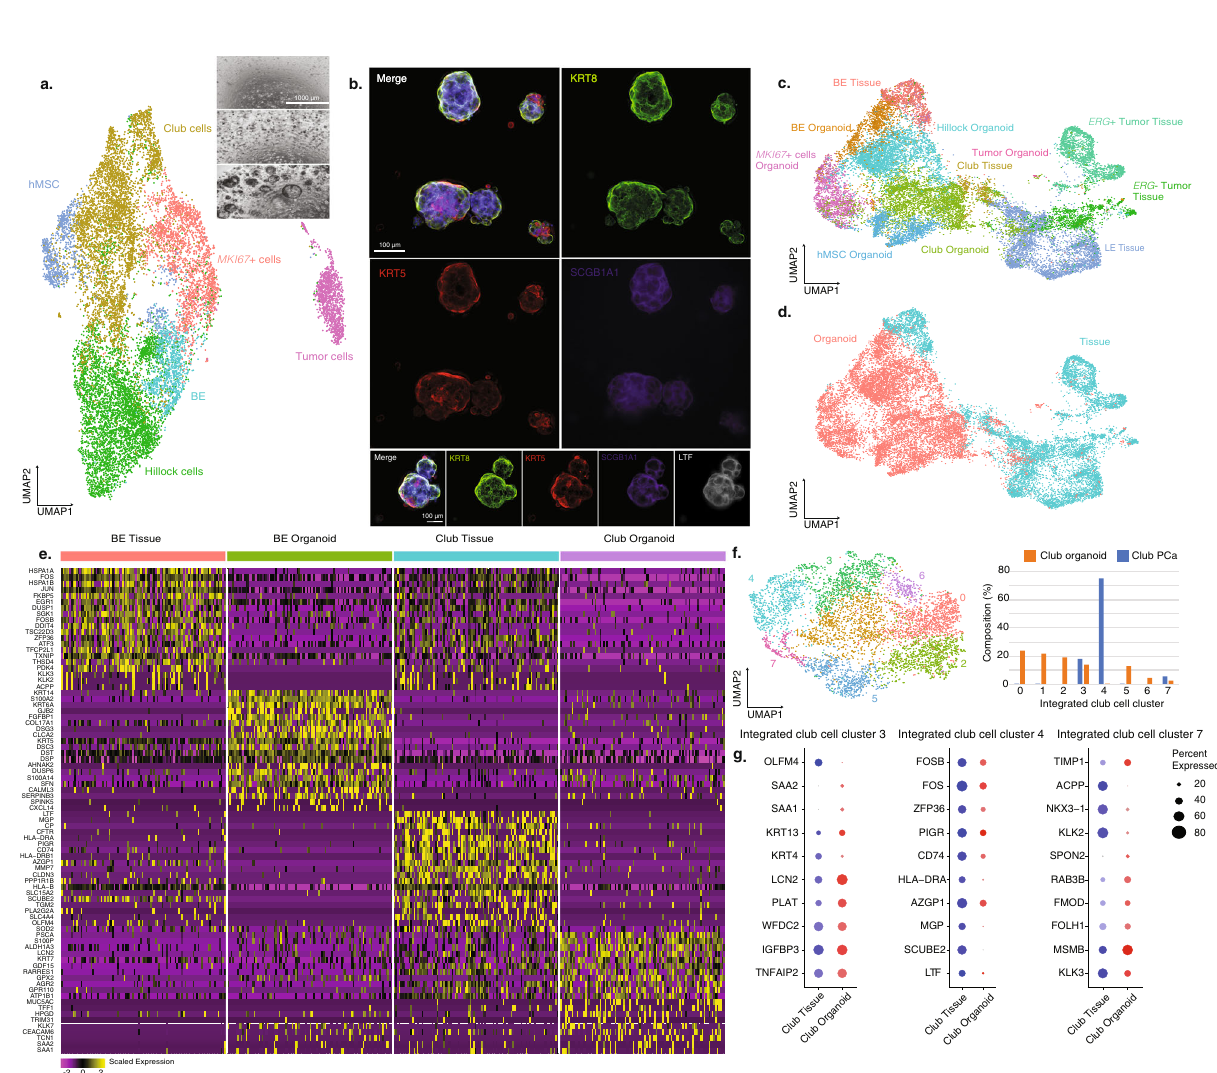
Fig. 8 In vitro organoid samples harbor PCa-enriched BE and club cell states. a UMAP of cells from organoid samples labeled by different cell types. Organoid culture snapshots are depicted in the upper right panel. b Immuno fl uorescence staining for LE marker ( KRT8 ), BE marker ( KRT5 ) and club cell markers ( SCGB1A1, LTF ) of the organoid samples. Technical and biological replicates for four additional organoids reproduce the shown staining. Due to the limitation of organoid sizes and subsequently image quality, only one group of experimental results is shown. c UMAP of the integrated dataset of cells from the organoid samples and epithelial cells from matching parent tissue samples, labeled by cell types. d UMAP of the integrated dataset, labeled by sample types (tissue or organoid samples). e Heatmaps for the top 20 differentially expressed genes for BE and club cells between tumor tissues and organoid samples. f UMAP of integrated club cell dataset of tumor tissue and organoid samples. Cell composition comparison is shown in the grouped bar charts. g Dot plots of the top ten differentially expressed genes in clusters 3, 4, and 7 in tissue and organoid club cells. Dot size represents proportions of gene expression in cells and expression levels are shown by color shading (low to high re fl ected as light to dark). Source data are provided as a Source Data fi